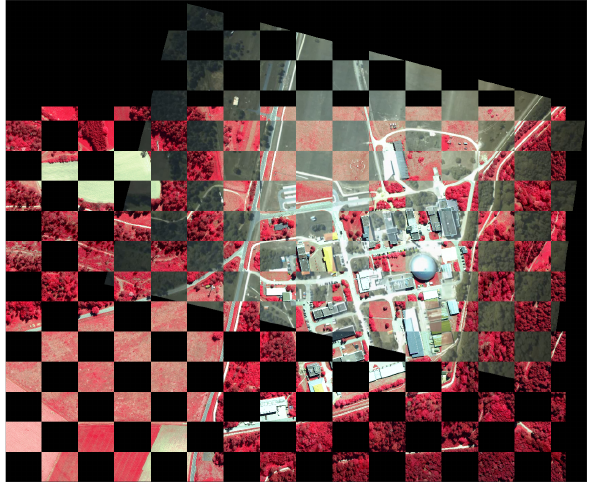
Figure 3. Result of the image registration representing both images alternating in a checkerboard pattern. pattern where both images are shown alternating. Points of the RGB image are provided in the coordinate system of the color infrared image.